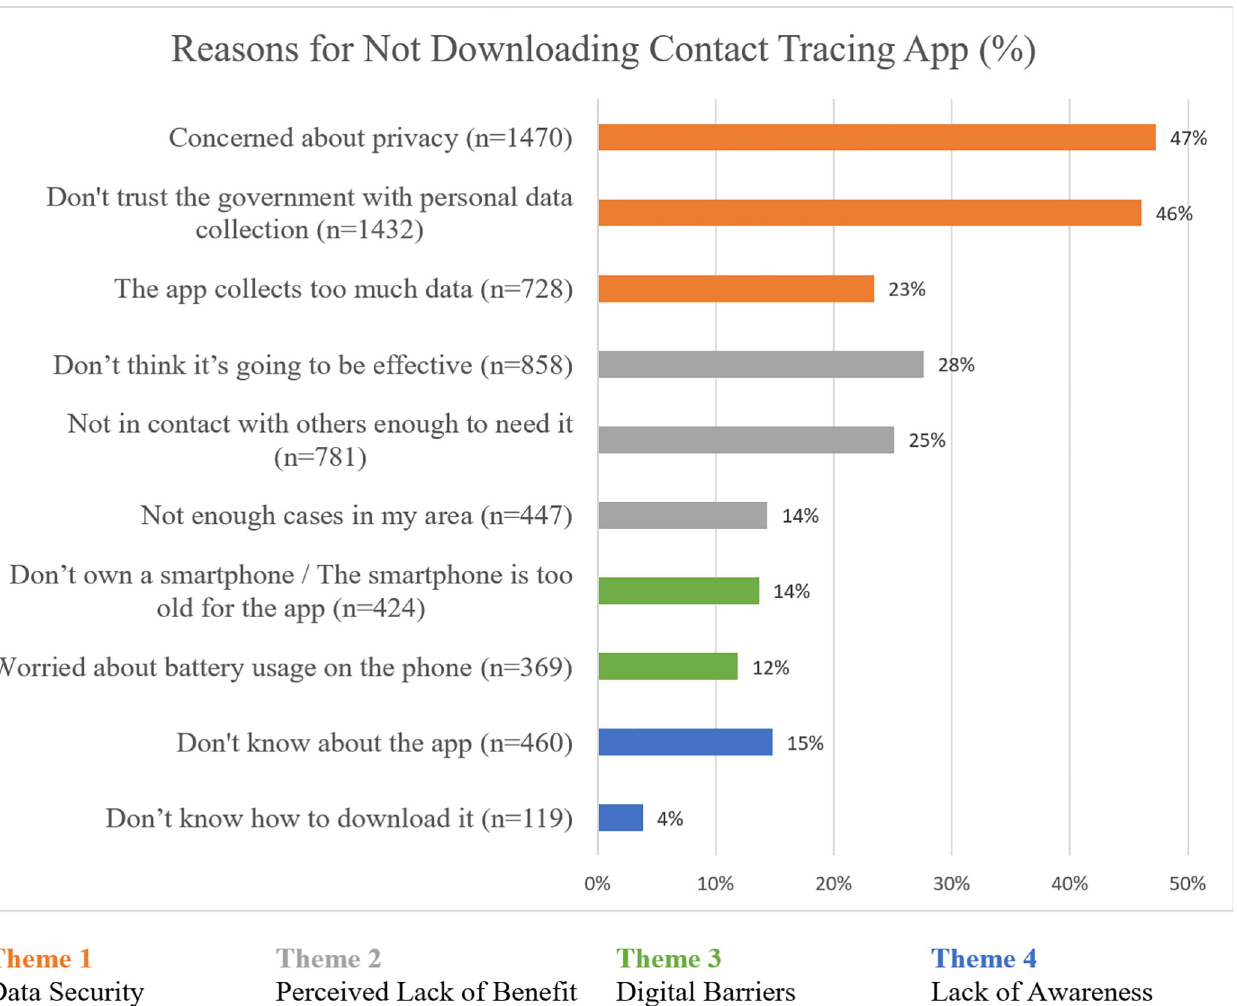
Fig 1. Reasons selected as contributing factors in the decision to not download a contact tracing app (n = 3109). Participants could choose more than one reason.